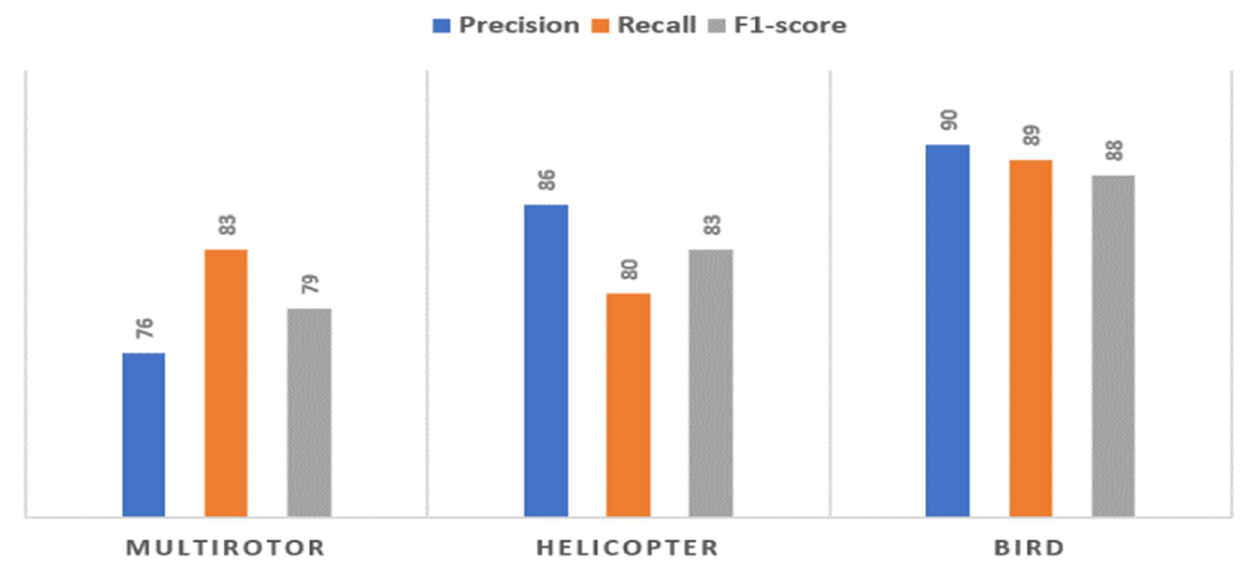
Figure 15. Evaluation metrics of the proposed CNN network.